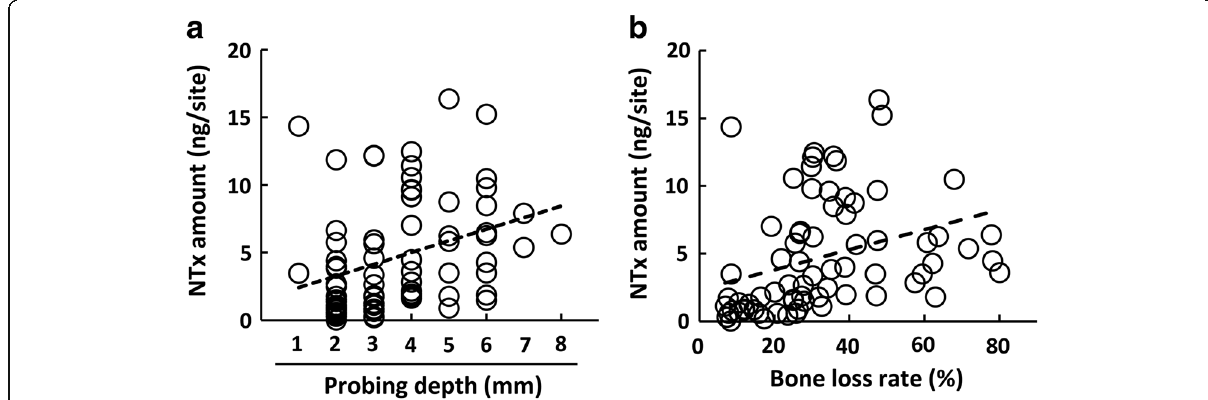
Fig. 4 Correlation between NTx amounts and PD or BL rates. a The correlation between PICF NTx amounts and PD was evaluated in PICF samples from peri-implant disease and healthy groups ( n = 74, ρ = 0.434, P < 0.001). b The correlation between PICF NTx amounts and BL rates (%) was evaluated in PICF samples from peri-implant disease and healthy groups ( n = 74, ρ = 0.570, P <